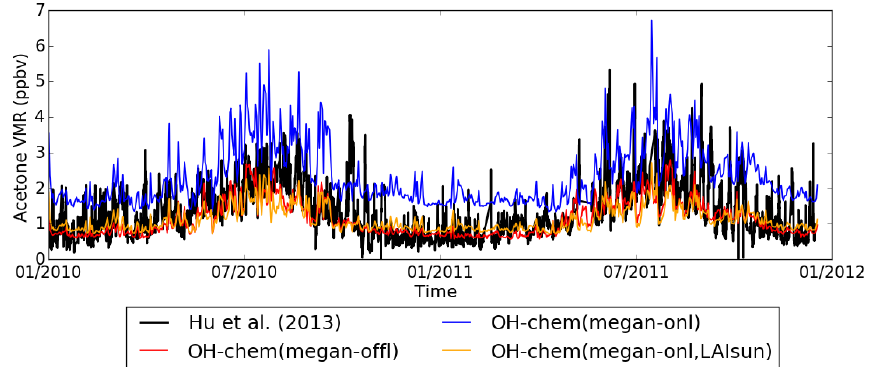
Figure 10. Measured (black) and simulated (red: OH-chem(megan-offl); blue: OH-chem(megan-onl); orange: OH-chem(megan- onl,LAIsun)) acetone VMR interpolated to the observation site in Minnesota (USA); see Hu et al. (2013). The measurement error of 10% is not included in the figure.